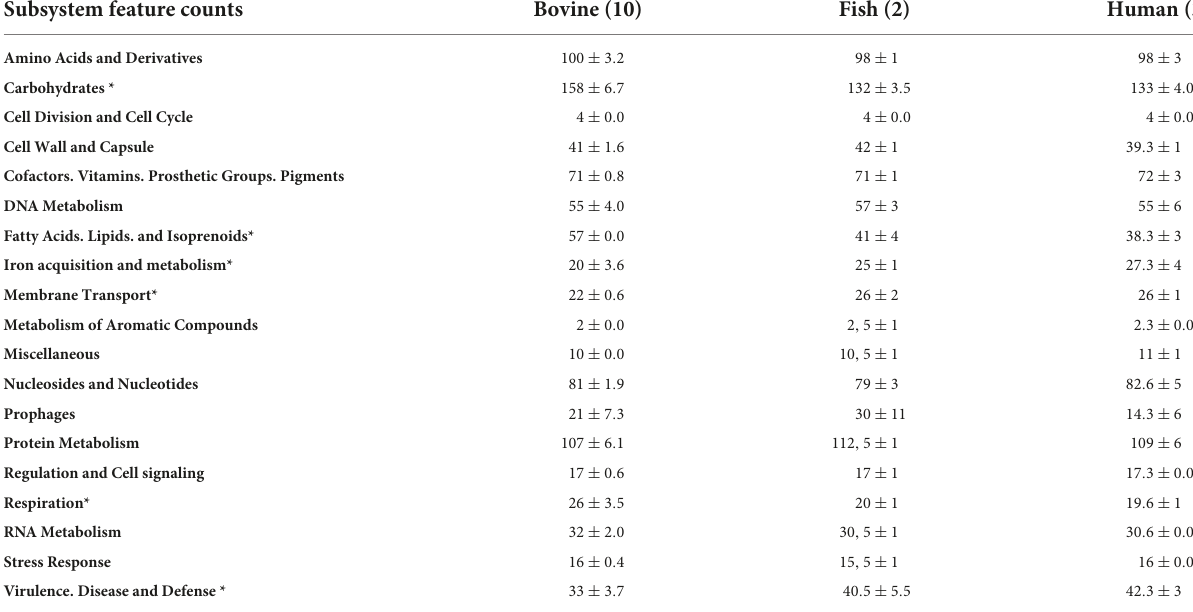
TABLE 1 Overview of the general characteristics SDSD genomes.